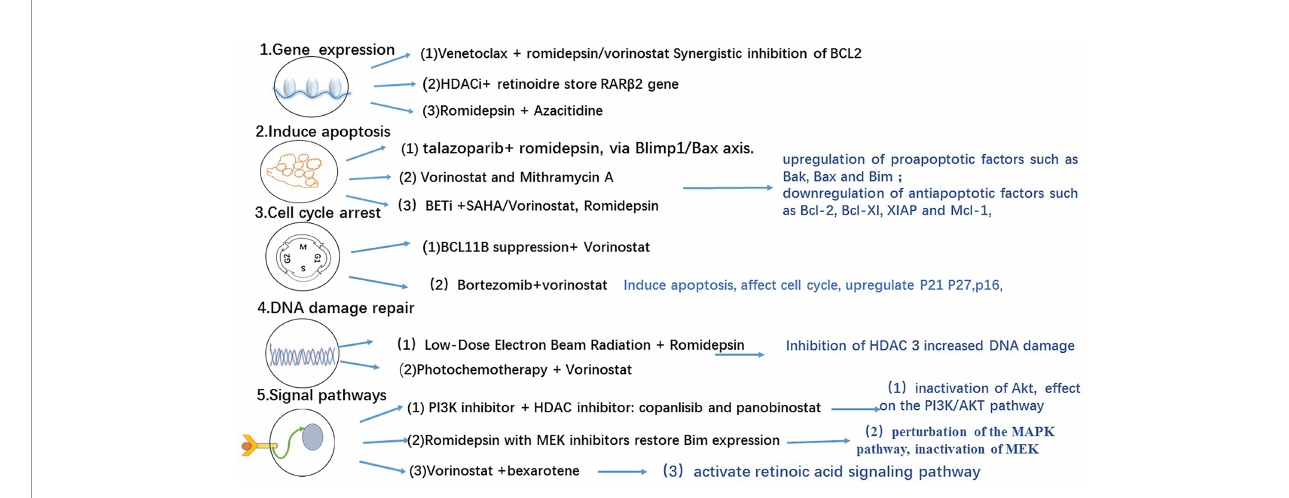
FIGURE 1 | HDACI combination therapy and effects